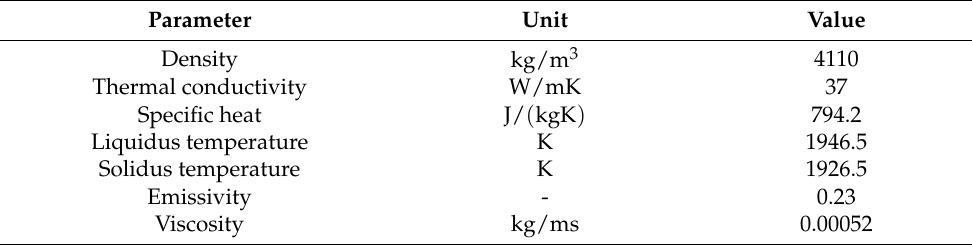
Table 1. Ti-6Al-4V